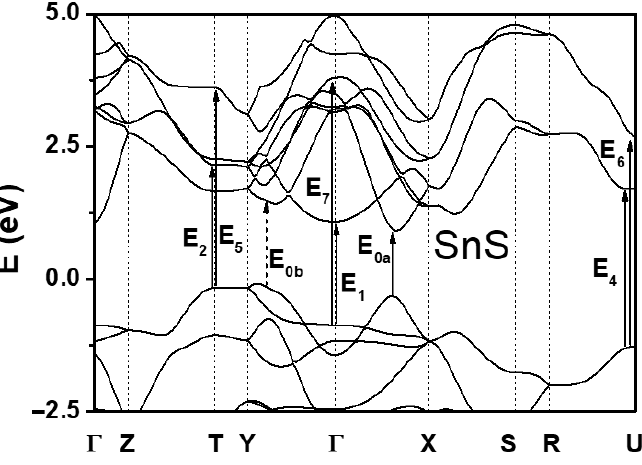
Figure 11. As Figure 10, but for SnS. Table 1. Comparison of room temperature CP energies of SnSe obtained along the a - and b -axes with those predicted from the 0 K energy band structure shown in Figure 10.